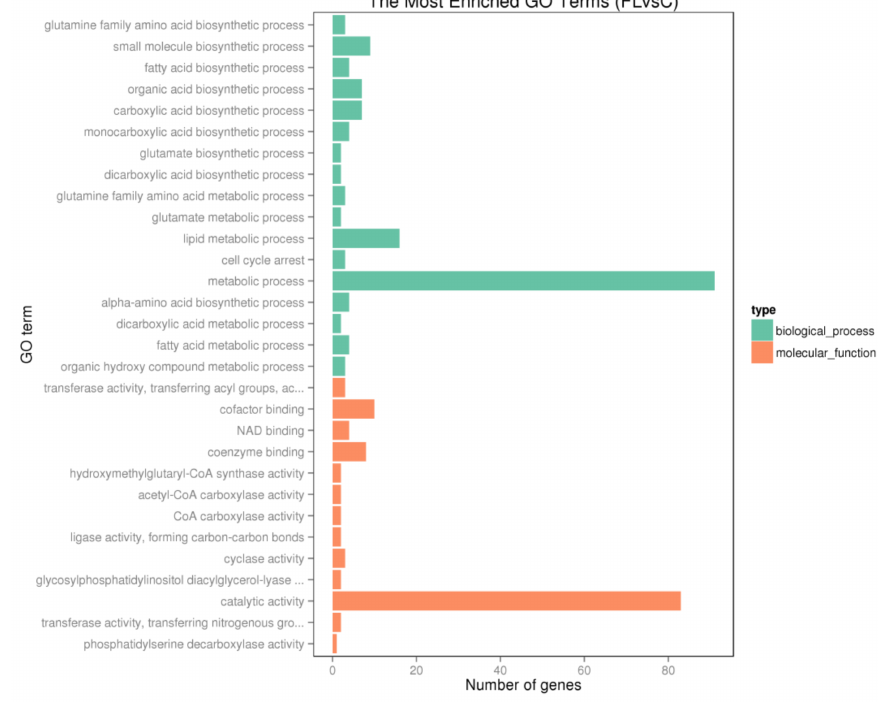
Figure 7. The most enriched gene ontology (GO) terms for the differentially expressed